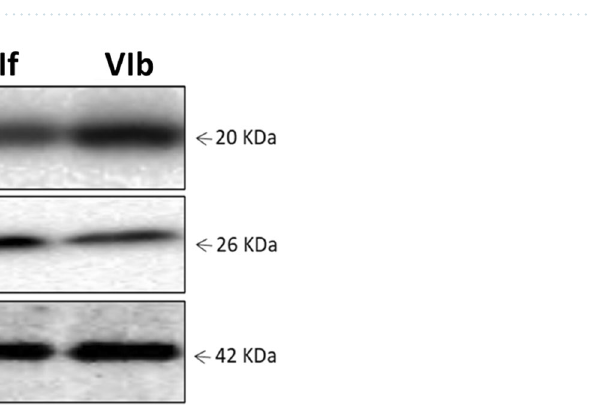
Figure 12. Apoptosis population distribution of ( IIIf ) and ( VIb ) treated MCF-7 cells after 24 h incubation. Analysis performed using BD FACS Calibur (https:// www. bdbio scien ces. com, BD Biosciences, San Jose, CA).